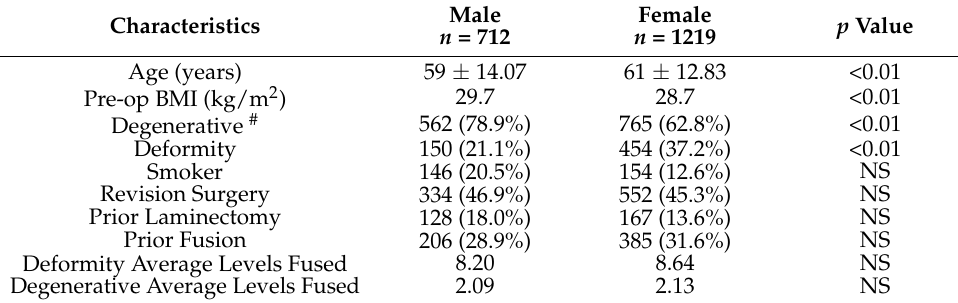
Table 1. Patient characteristics separated by gender.